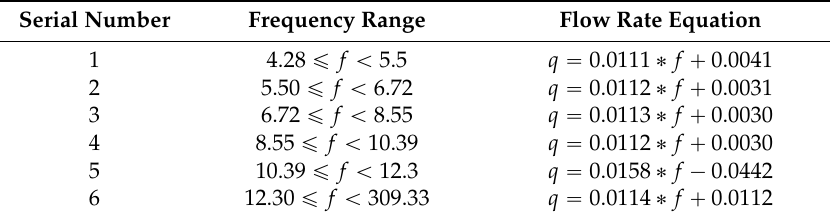
Table 4. The segment linearization model of fiber turbine flow sensor.